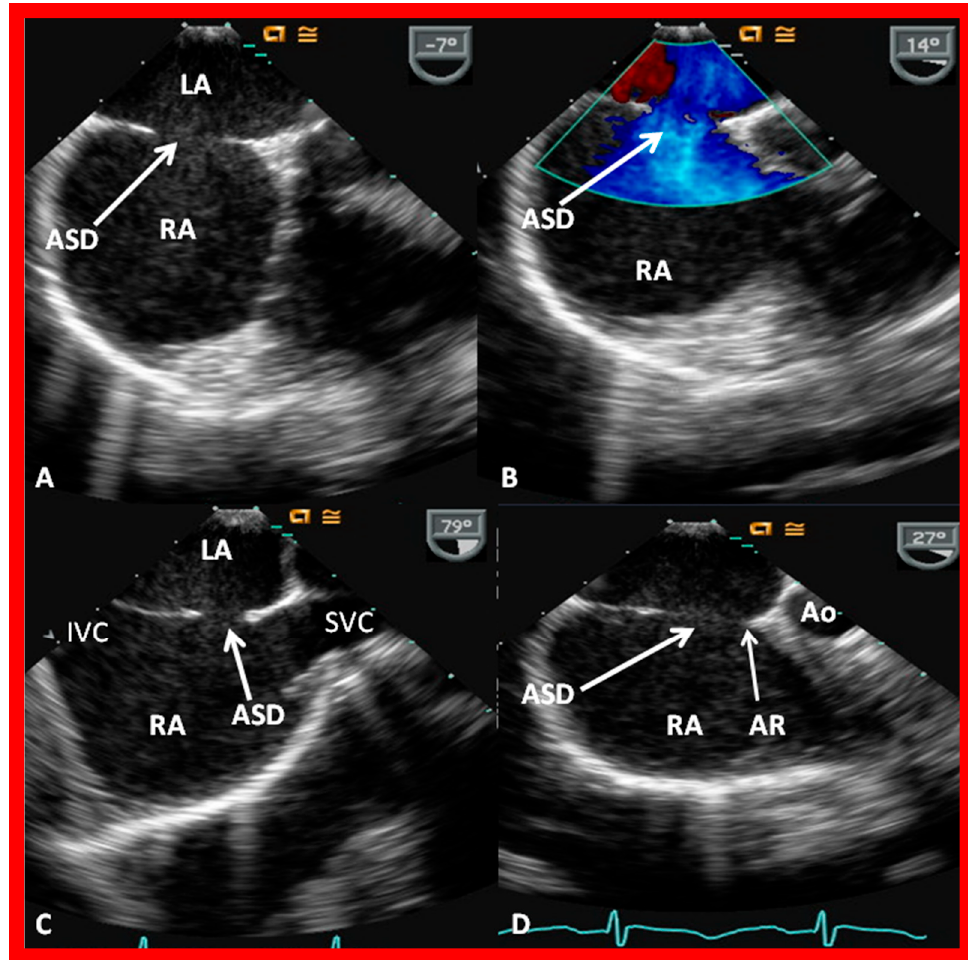
Figure 14. Transesophageal echocardiographic examination demonstrating an atrial septal defect (ASD) in long-axis ( A , B ), bi-caval ( C ), and short-axis ( D ) views. Shunt across the ASD is shown by color flow imaging ( B ). Note the very small aortic (anterio-superior) rim (AR) in ( D ). A good-sized superior vena caval (SVC) rim is seen in ( C ). Aorta (Ao), inferior vena cava (IVC), left atrium (LA), and right atrium (RA) are marked. Reproduced from Reference [6].